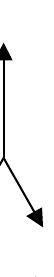
Figure 8. Cogging torque phasors diagram.